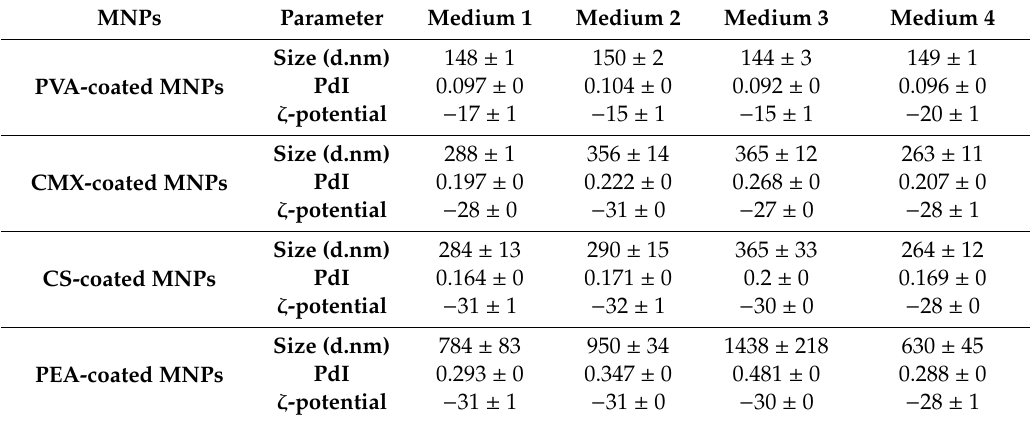
Table 4. Physicochemical properties of PVA-, CMX-, CS-, and PEA-coated MNPs suspended in four di ff erent culture media. See Table 2 for the components and concentrations of the media. Mean and standard deviation of the mean (n = 3).